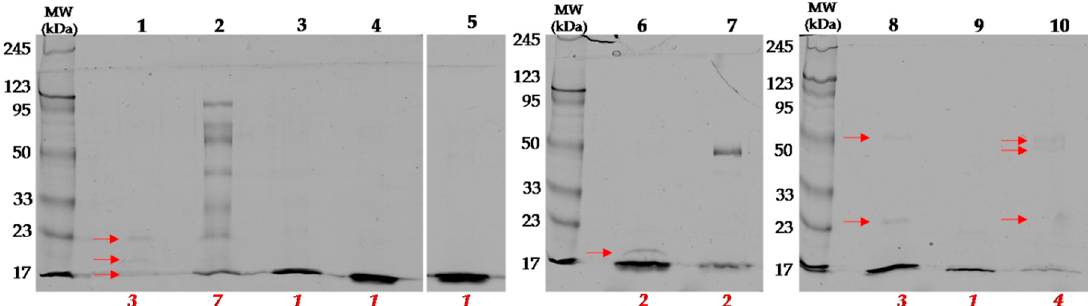
Figure 3. Representative SDS-PAGE gels of Naja ashei venom fractions. The numbers above the lines represent the fractions collected. The numbers below lines (red) indicate the number of bands defined in the ImageJ software. Weakly visible bands are marked with arrows on the